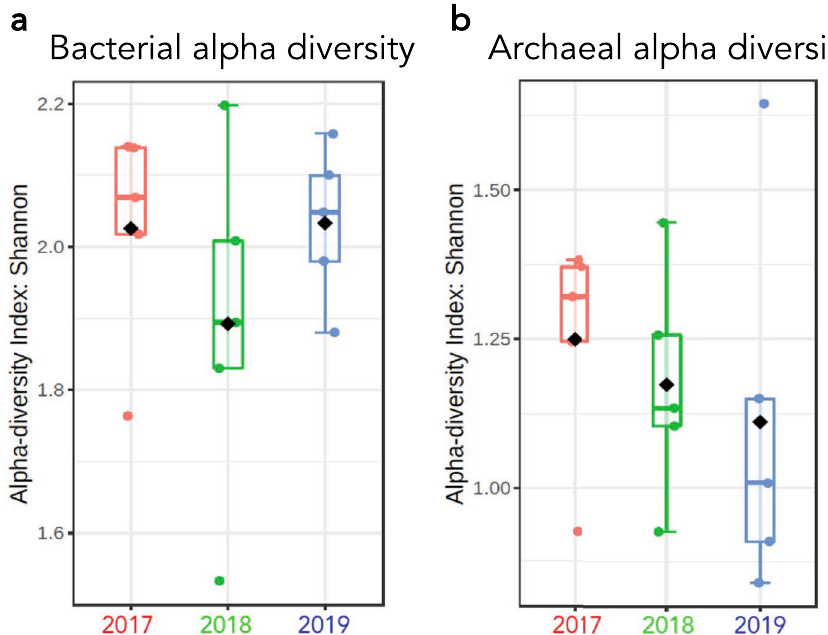
Figure 3. Microbial alpha diversity was calculated using a Shannon Index for all springs each year. ( a ) Bacterial alpha diversity from 2017 to 2019. ( b ) Archaeal alpha diversity from 2017 to 2019. Shannon Index analysis accounts for both the evenness and richness in a